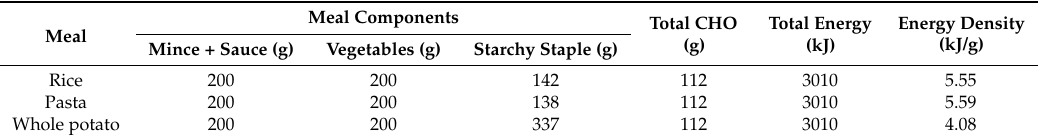
Table 1. Test meal